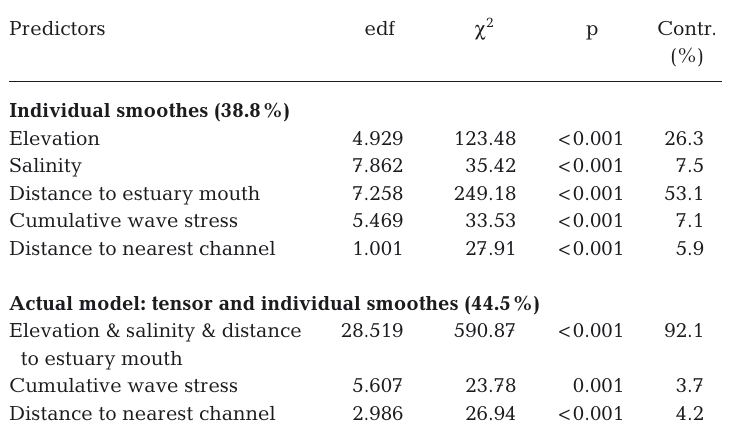
Table 2. Relative contribution of predictor variables to the generalized addi- tive model (GAM) model for Zostera marina in 2005 (see Table S1 in the Sup- plement for 2006 and 2009 results). Contributions of individual predictors are shown for a model with smoothing for each predictor. The final model incorpo- rates a tensor smoothe including 3 predictors and individual smoothes for 2 predictors. Deviance explained is given in parentheses. edf = estimated degrees of freedom, χ 2 value reflects the relative importance of each predictor in the model. The p-values are provided but are only useful for identifying predictors that do not contribute to the